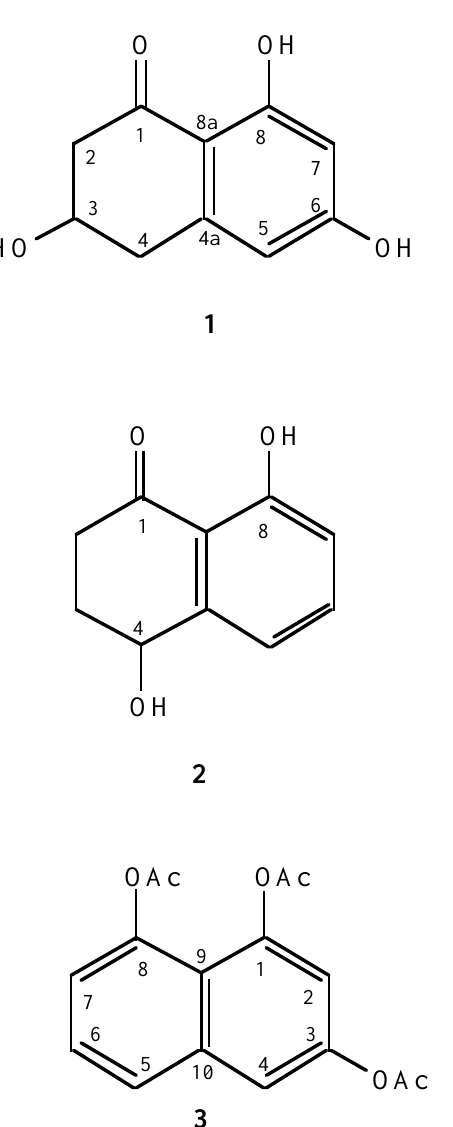
Fig. 1. Structure formulae of scytalone ( 1 ), isosclerone ( 2 ), and 1,3,8-triacetoxynaphthalene ( 3